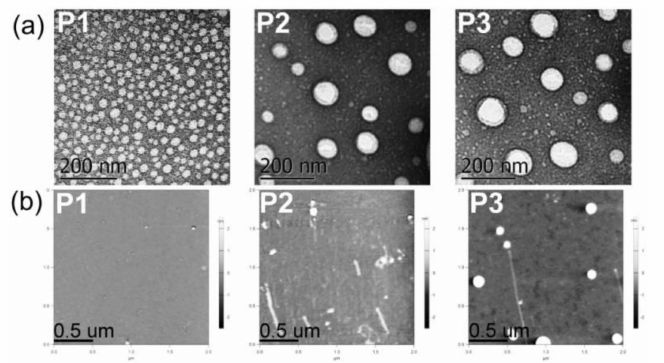
Figure 3. ( a ) TEM micrographs of P1–P3 dried nanoaggregates at 21,000 × magnification. ( b ) AFM micrographs of P1–P3 dried nanoaggregates (see structures in Figure